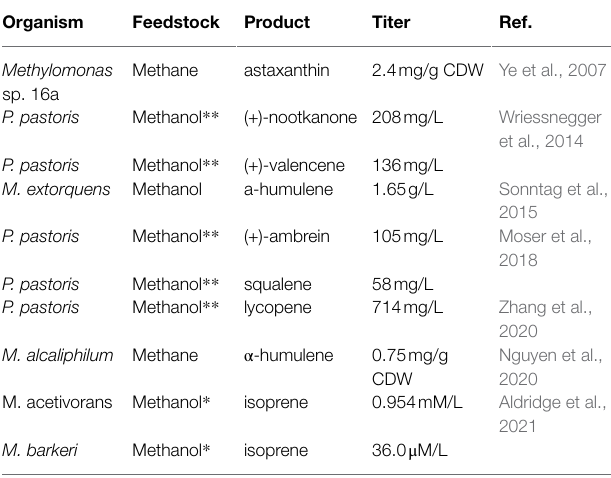
TABLE 2 | Production of isoprenoids by methylotrophic organisms. Organism Feedstock Product